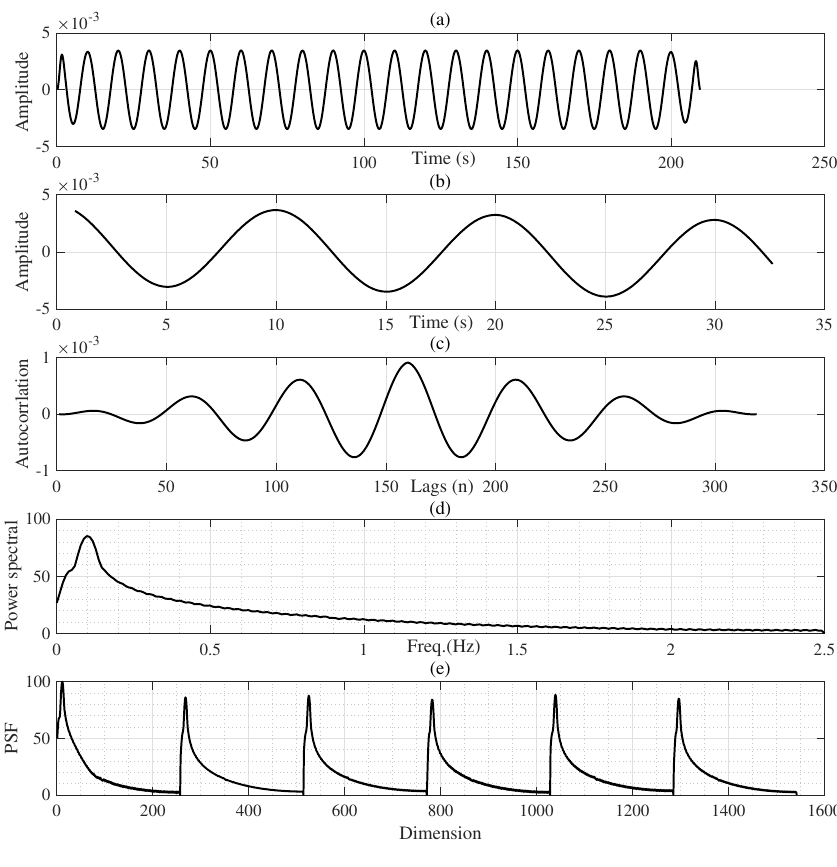
Figure 3. Top panel ( a ) is a resampled wave signal from the 2nd subject PPG signal, panel ( b ) is a segmented wave signal from the resampled wave signal ( a ), panel ( c ) denotes an autocorrelation signal from the segmented wave signal ( b ), panel ( d ) is a power spectral from ( c ) the autocorrelation signal, and bottom panel ( e ) denotes the power spectral feature (PSF) from the power spectral ( d